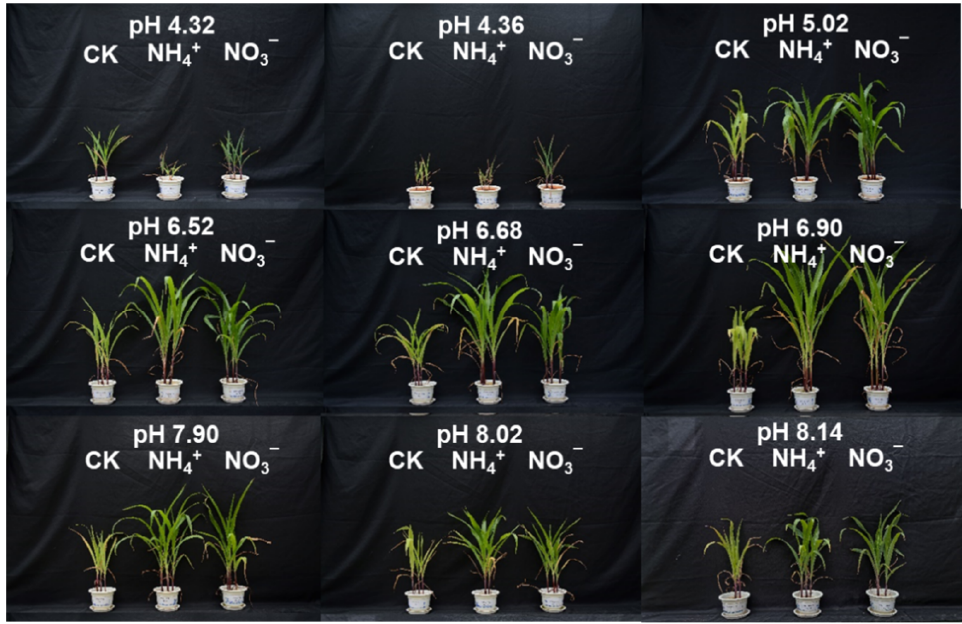
Figure 1. Maize seedlings after 30 days of growth with non-N (CK), NH 4+ , or NO 3− at different soil pHs.